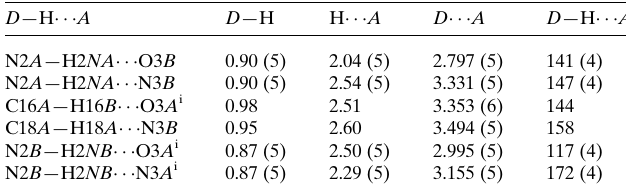
Table 2 Experimental details.